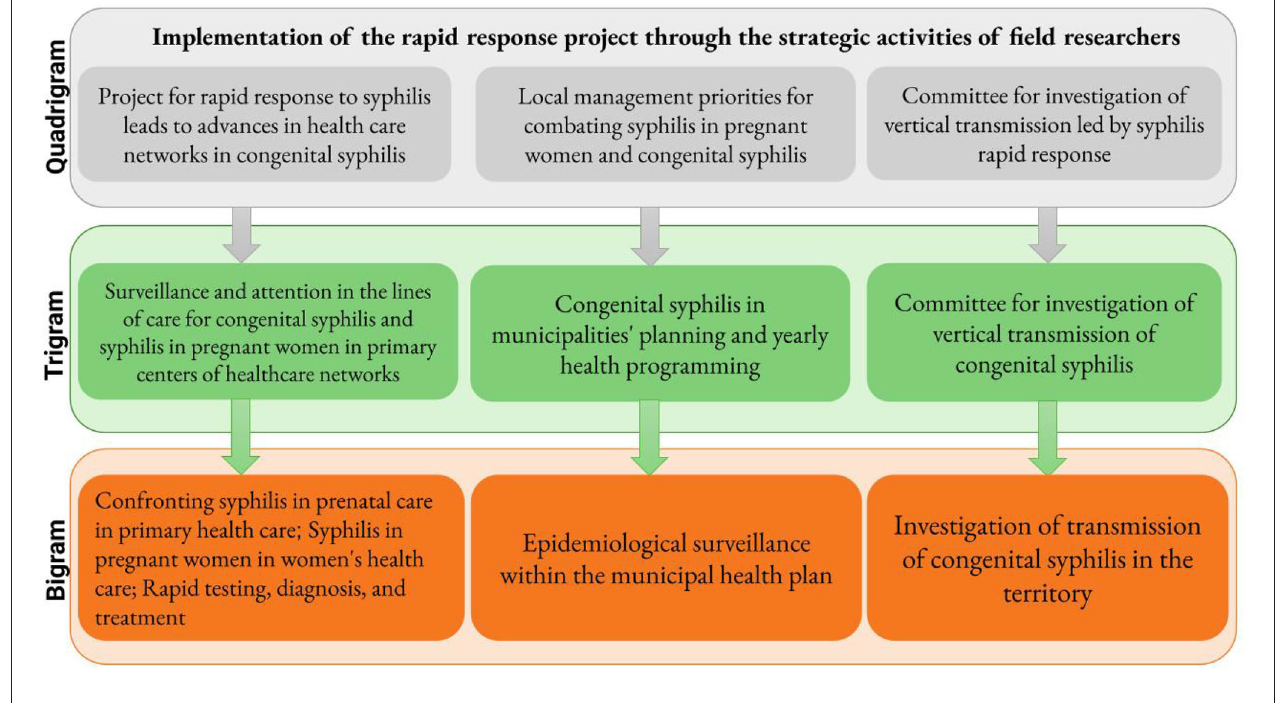
FIGURE 11 | Flow diagram of literature